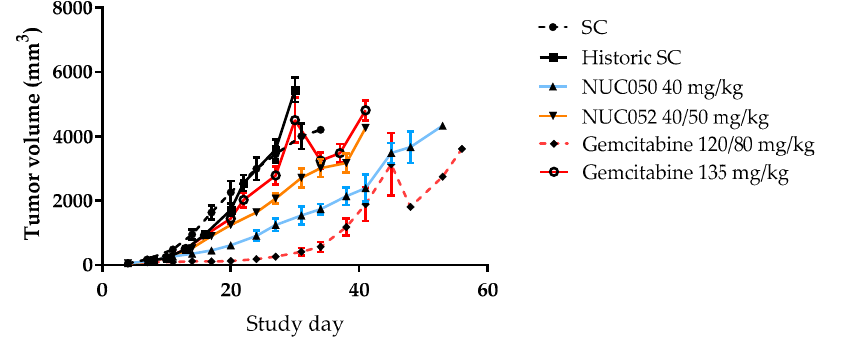
Figure 4. Comparison of mean tumor volumes (±SEM) in mice with human NSCLC. NCI-H460 implants treated with NUC050, NUC052 or gemcitabine ( n =10 per group). SC mice are those treated contemporaneously with NUC050, NUC052 or gemcitabine 120/80 mg/kg as per regimen in Figure 3. Historic SC mice were from a previous experiment comparing SC to gemcitabine 135 mg/kg IV q5d × 3.